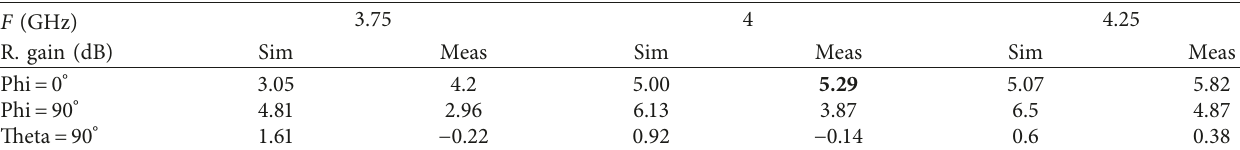
Figure 13: Simulated and measured radiation patterns in dB in free-space of the reflector-backed antenna. Table 4: Simulated and measured maximum realized gain of the reflector-backed